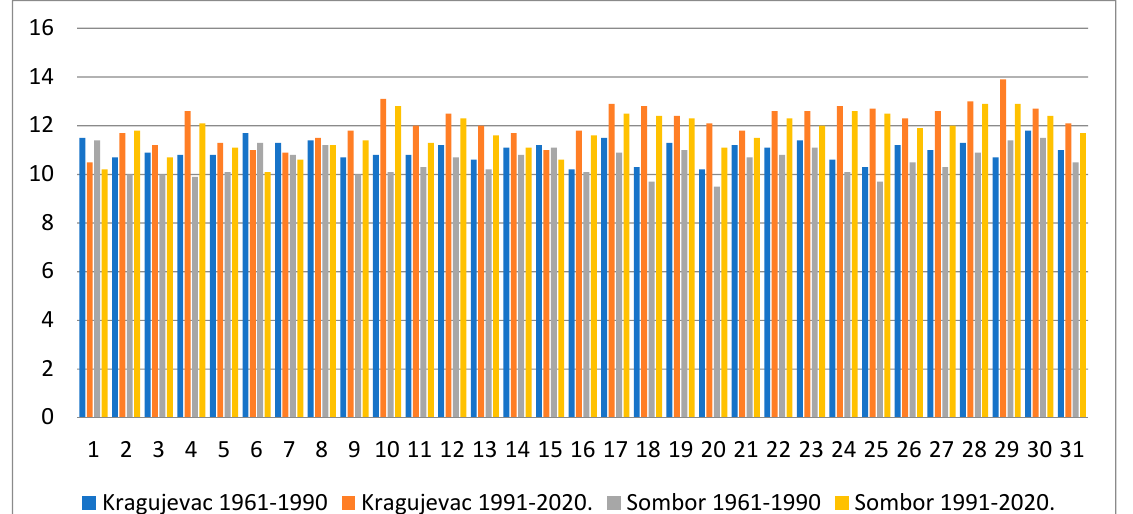
Figure 1. Average temperatures per year and two long period 1961–1990 and 1991–2020 in Kragujevac and Sombor. Remark: 1–30 are average t values per year for each period and each region; 31-average values for each period and each region.